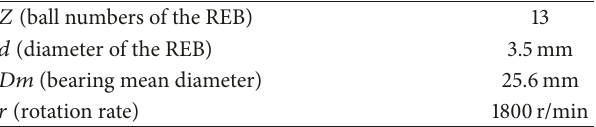
Table 3: Characteristics of tested